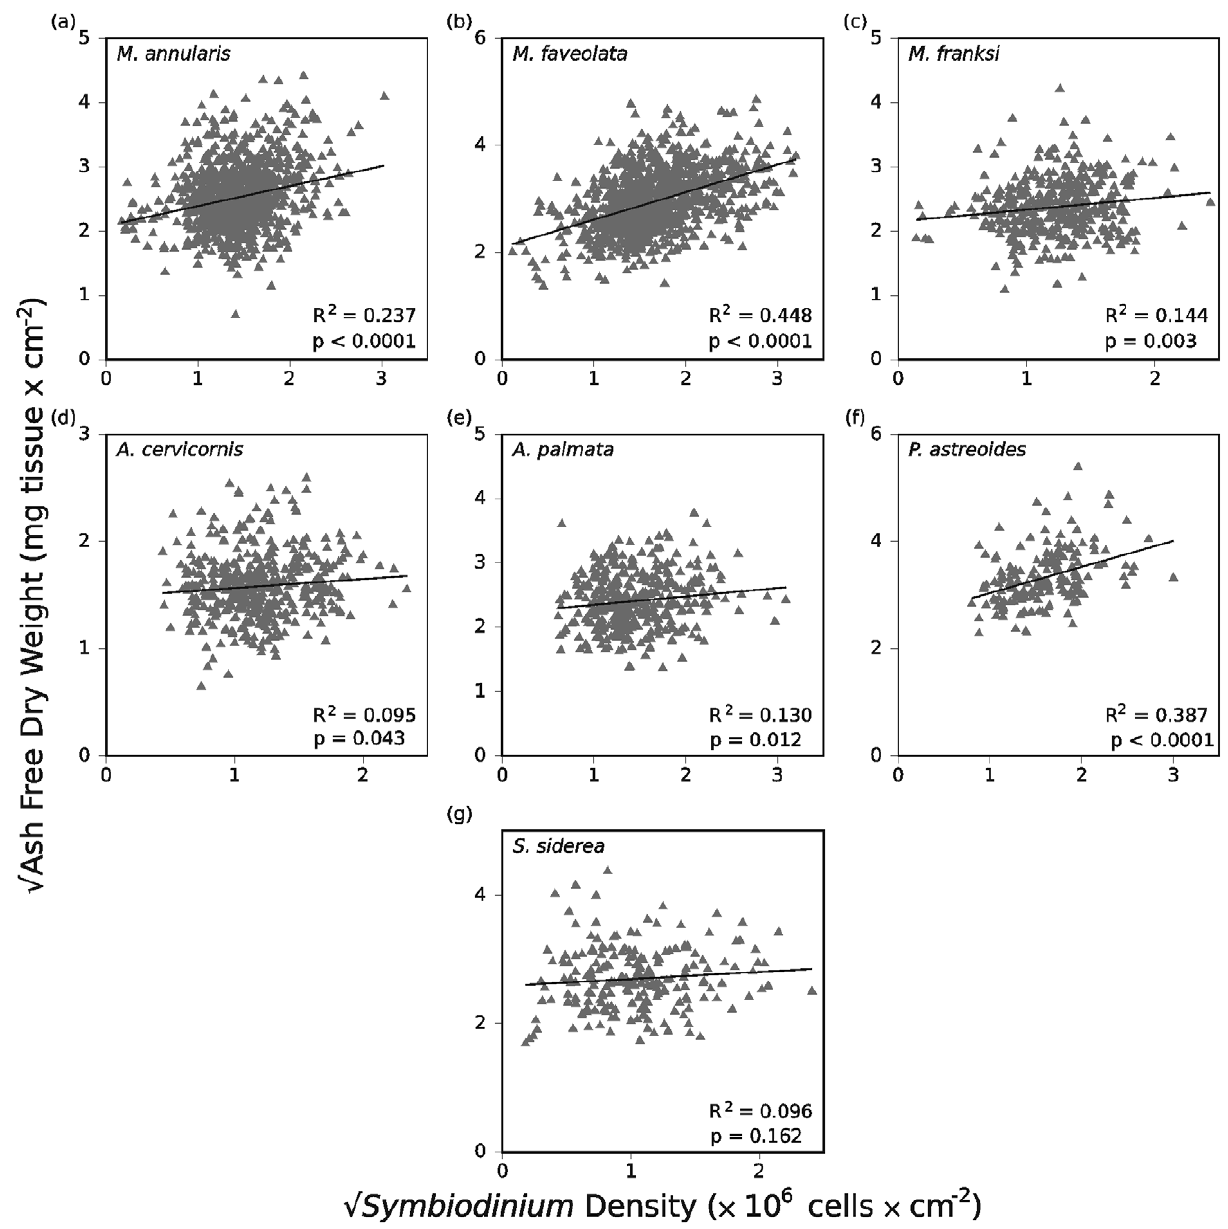
Figure 3. Scatter plots depicting the relationship between tissue biomass versus Symbiodinium density for seven reef-building corals. Data have been square root transformed in order to meet normality assumptions and a trend line has been fitted to the transformed dataset for each species. Coral species identity (upper left), degree of correlation (R 2 value, lower right), and p value (lower right) are provided for each